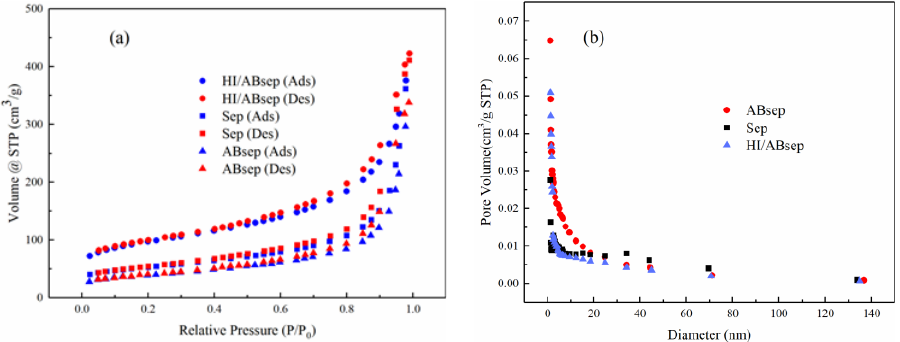
Figure 1. N 2 adsorption–desorption isotherm at 77 K ( a ) and BJH pore size distribution ( b ) of Sep, ABsep, and HI/ABsep.